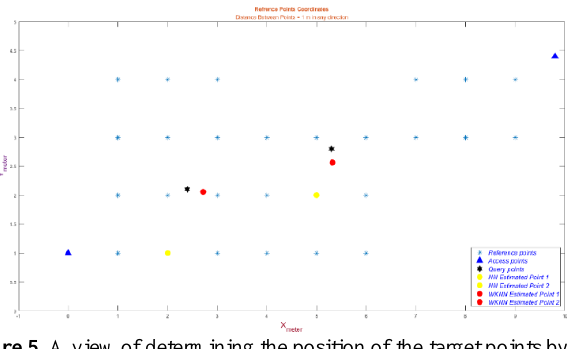
Table 4. RMSE for positioning methods in all scenario